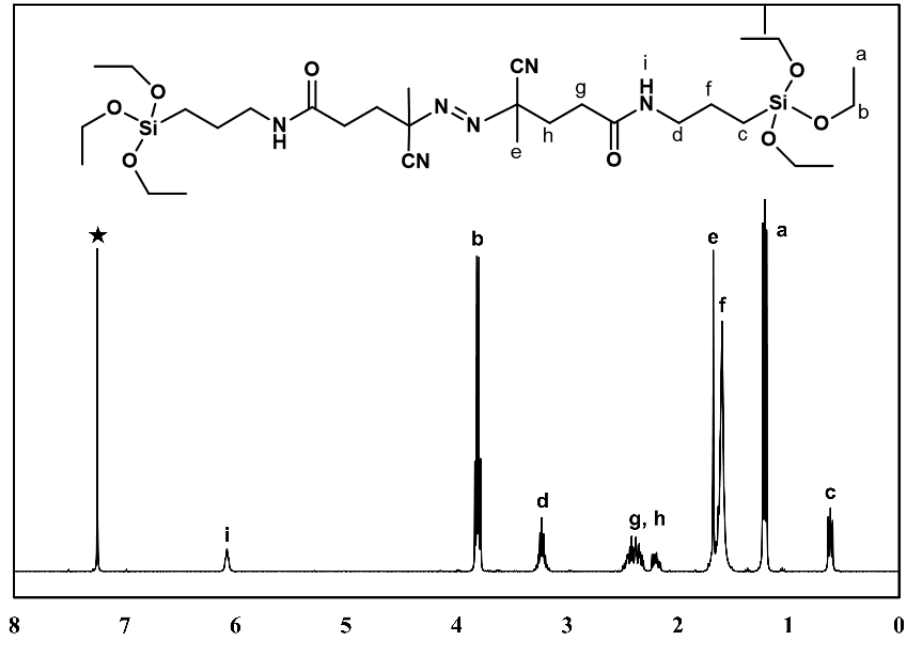
Figure 1. 1 H NMR spectra of the difunctional initiator ( ★ CDCl 3 solvent). Chemical shifts ( δ ) are reported with an internal standard, tetramethylsilane, and the 1 H NMR peaks are shown below: 1 H NMR (CDCl 3 ): δ ppm 0.64 (t, 4H, Si-C H 2 -), 1.23 (t, 18H, SiO-CH 2 -C H 3 ), 1.62 (q, 4H, Si-CH 2 -C H 2 ), 1.70 (s, 6H, C-C H 3 ), 2.16–2.52 (m, 8H, CO-CH 2 -C H 2 , CO-C H 2 ), 3.52 (m, 4H, NH-C H 2 ), 3.84 (q, 12H, SiO-C H 2 -).